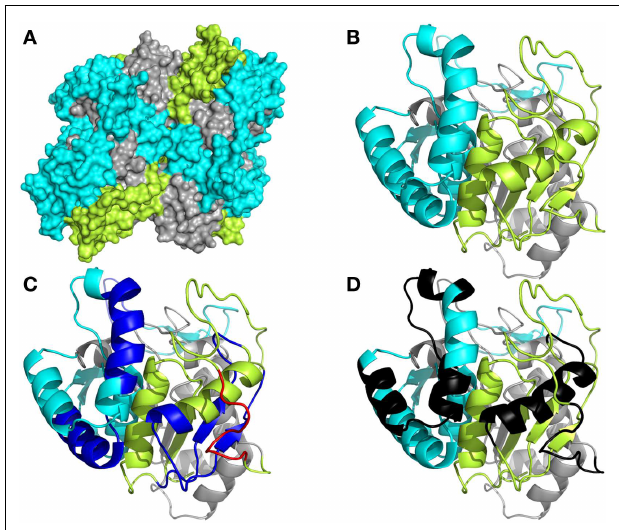
FIGURE 1 | Spatial distribution of epitopes in the monomer of Leishmania donovani nucleoside hydrolase-NH36 . (A) Illustration of the tridimensional surface model of the NH36 tetramer obtained by homology modeling to the sequence of the nucleoside hydrolase of L. major . (B) Monomer of L. donovani NH36 with the sequences of the N-terminal (F1, amino acids 1–103 in lime green), central (F2, amino acids 104–198 in gray), and C-terminal (F3, amino acids 199–314 in cyan) moieties. (C) MHC class II-IAd and IEd, haplotype H2d CD4 + T cell epitopes (dark blue), and of MHC class I Ld-CD8 + T cell predicted epitopes (red) of the C-terminal and N-terminal moieties. (D) Epitopes for B cells on the C-terminal and N-terminal moieties (black).